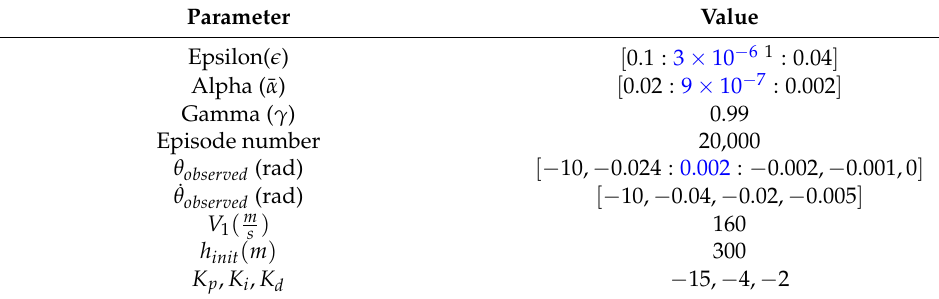
Table 5. Q-learning and PID simulation